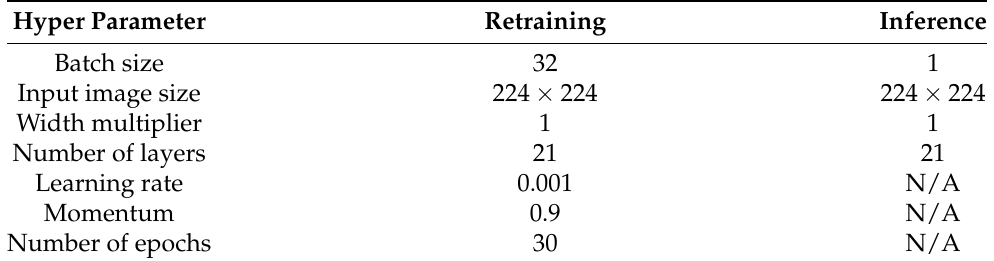
Table 5. MobileNet V2 hyperparameters used for retraining and inference (N/A: not applicable).